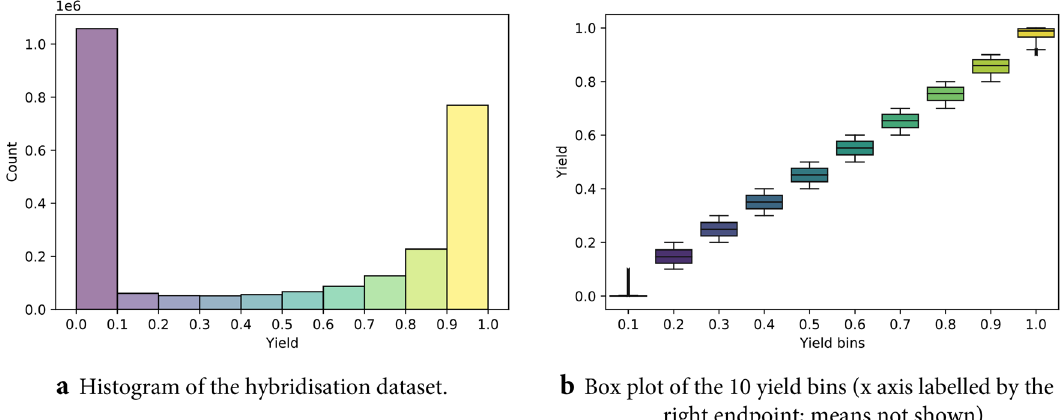
Figure 2. Visual summary of the yield distribution at 57 °C (the temperature used throughout the paper). For a discussion on the behaviour of the yield at different temperatures, see Supplementary Information 14. The yield is binned in 10 groups, each spanning a 0.1 interval. Brighter colours correspond to higher yield and are shared for the two subfigures. ( a ) Low and high values are the most numerous, which is expected considering our generative procedure. ( b ) The highest density is achieved at the extremes of 0, respectively 1. Given how sensitive the molecules are even to a 1-base change, we count the entire intermediate range of yields [0.1, 0.9) as one entity when considering how balanced the dataset is. In this regard, 1,058,364 pairs achieve low yields ( < 0.1 ), 769,750 achieve very high yields ( ≥ 0.9 ) and 728,862 are in-between. It is important that samples